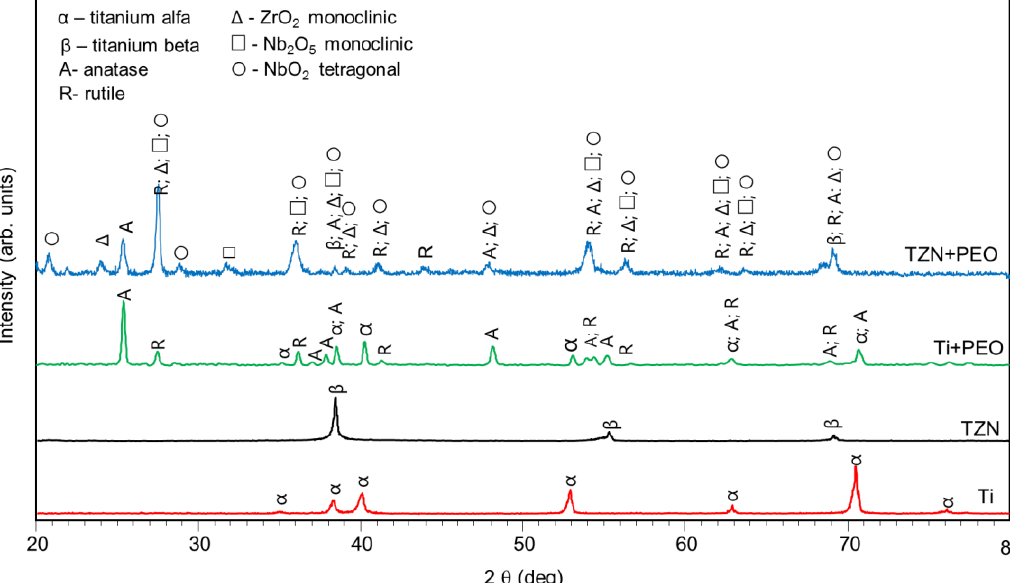
Figure 4. X-ray diffractograms for the uncoated and PEO coated Ti and TZN samples (PDF reference pattern numbers: α- titanium (00-044-1294), β -titanium (98-007-1749), anatase (01-083-2243), rutile (01-072-1148), m-ZrO 2 (98-009-0936), m-Nb 2 O 5